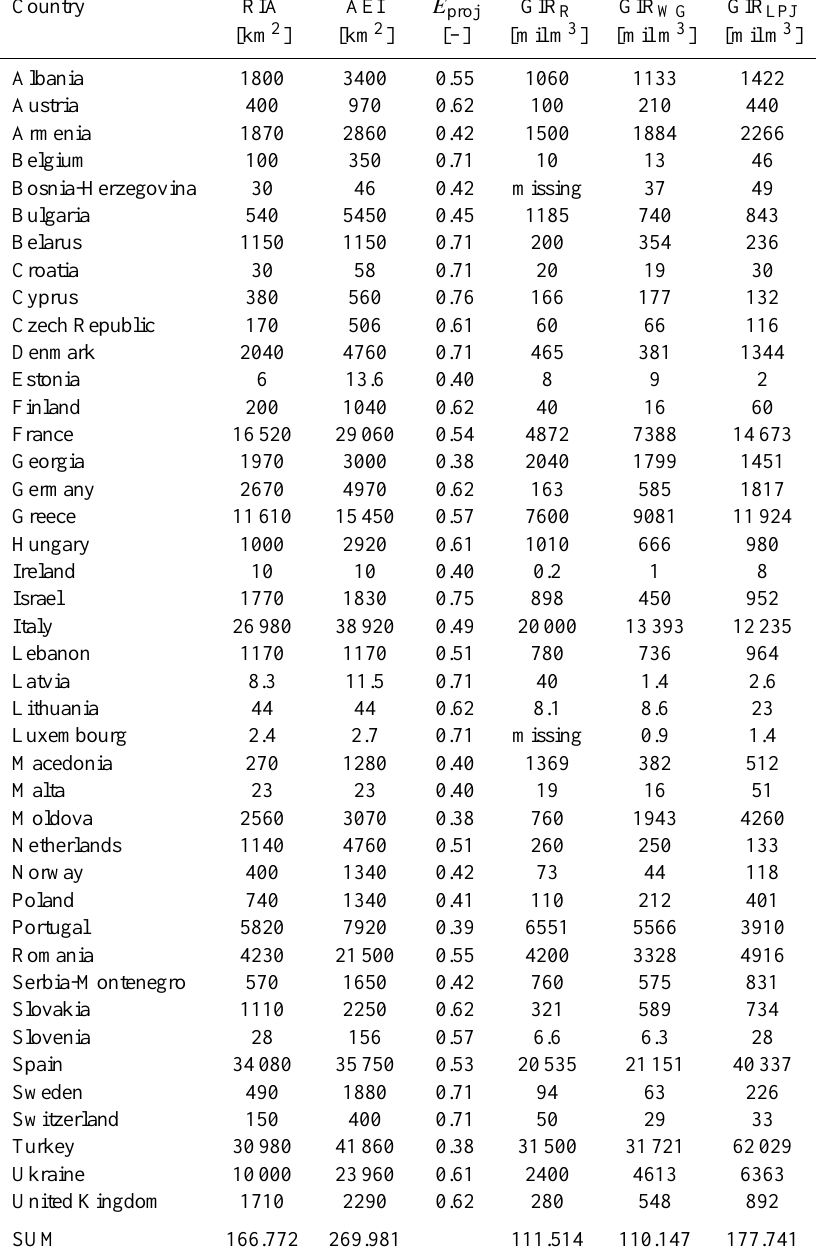
Table 1. Country based RIA (Real Irrigated Area), AEI (Area Equipped for Irrigation), E proj (irrigation project efficiency), GIR R (reported Gross Irrigation Requirements), GIR WG (modelled Gross Irrigation Requirements from WaterGAP3), GIR LPJ (modelled Gross Irrigation Requirements from LPJmL). Please note that Azerbaijan, Iran, Iraq, Jordan, Russia, and Syria are not included in this table, as they are not fully embedded within the pan-European